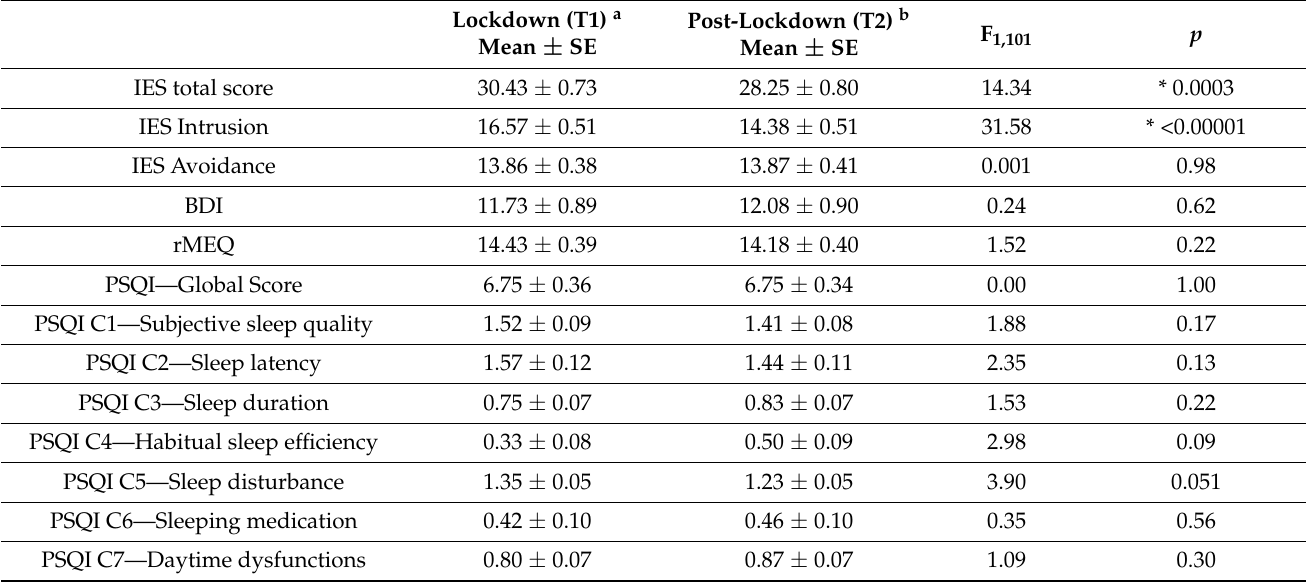
Table 4. Results of the comparisons (univariate ANOVAs) between lockdown (T1) and post-lockdown (T2) clinical, sleep, and sleep-related measures. Mean and standard errors (SE) are reported for the two time points. Asterisks index significant differences ( p <